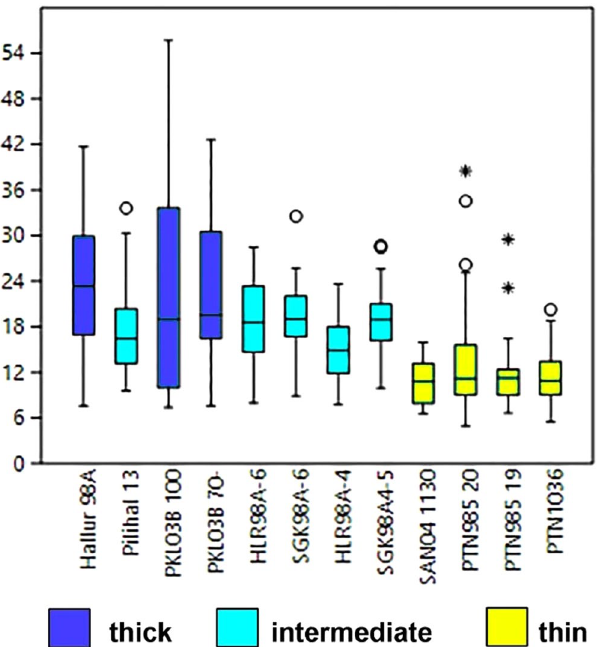
Figure 6. Boxplots of archaeological testa thickness measurements, colour-coded into suggested thick (wild), intermediate and thin (domesticated) testa grades. Boxed areas are the 25th and 75th percentile around the median. Outliers are indicated for measurements at more than 3 times the height of the box; all other measurements fall within the whiskers. Raw data in Table S4.